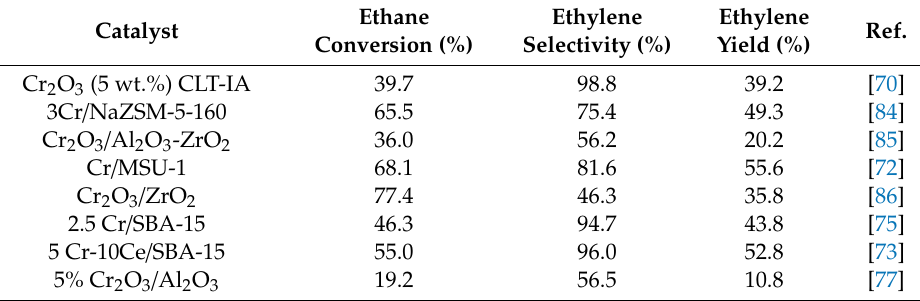
Table 9. Influence of CO 2 on oxidative dehydrogenation of